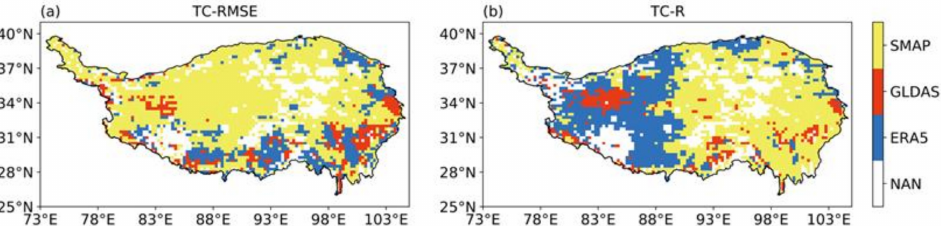
Figure 8. Optimal product with ( a ) the lowest standard deviation of random errors derived from triple collocation (TC-RMSE) and ( b ) the highest triple collocation correlation coefficient (TC-R) for each grid cell. Blank indicates missing values due to violation of triple collocation assumptions.